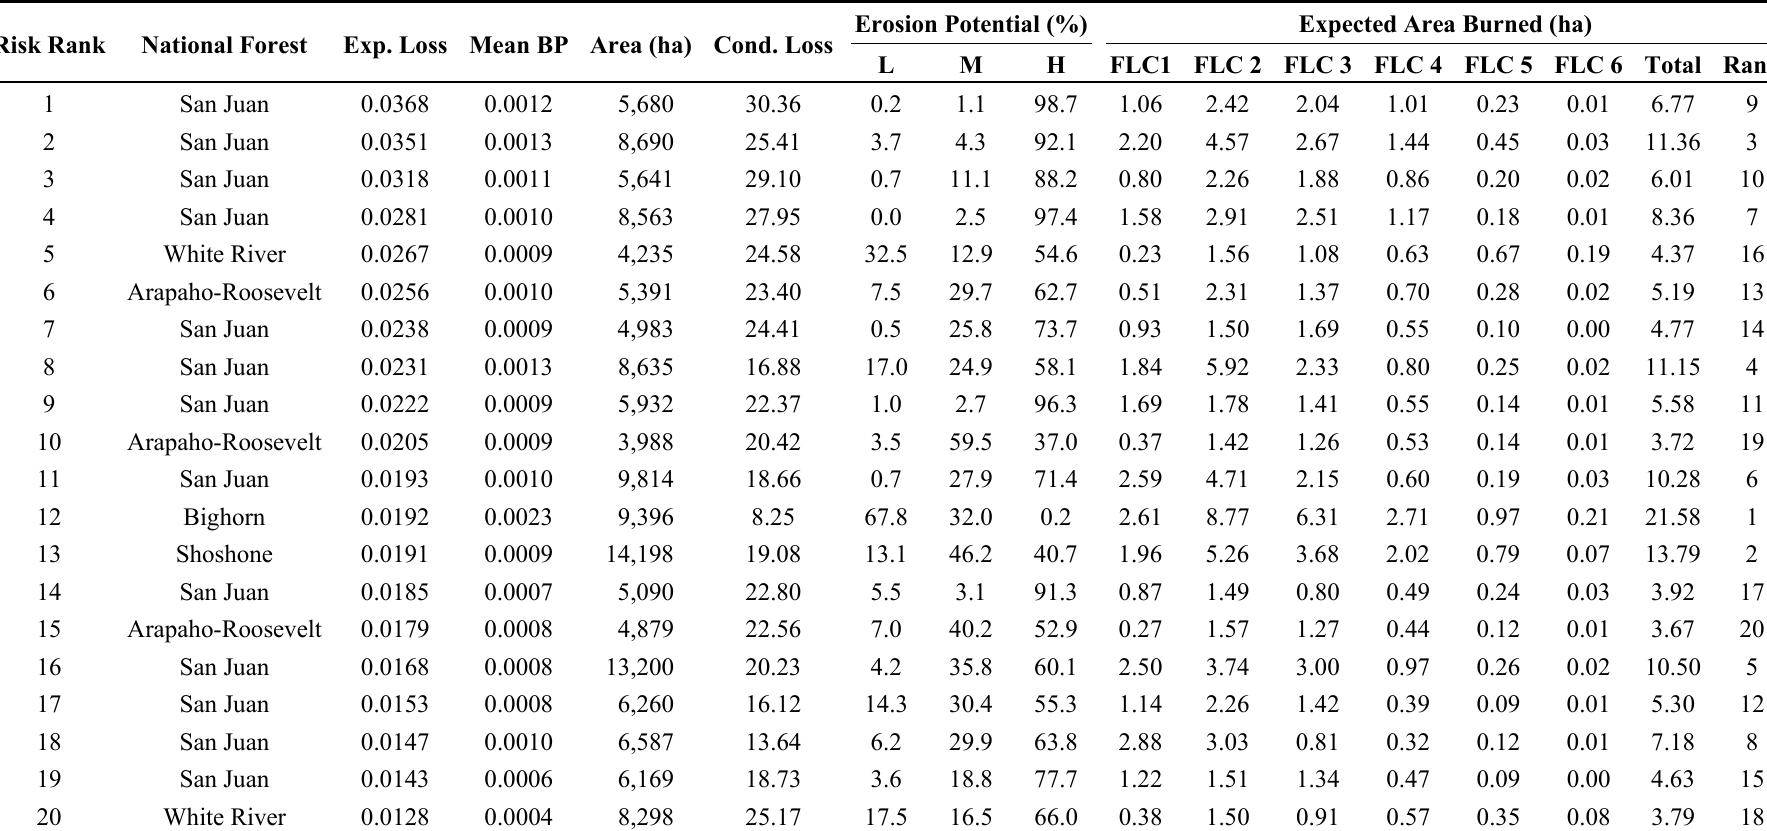
Table 2. The top 20 at-risk watersheds, ranked according to expected (exp.) loss. Information is presented on watershed mean burn probability (BP), size, conditional (cond.) loss, erosion potential (in burnable areas), and expected area burned by flame length class (FLC). Risk